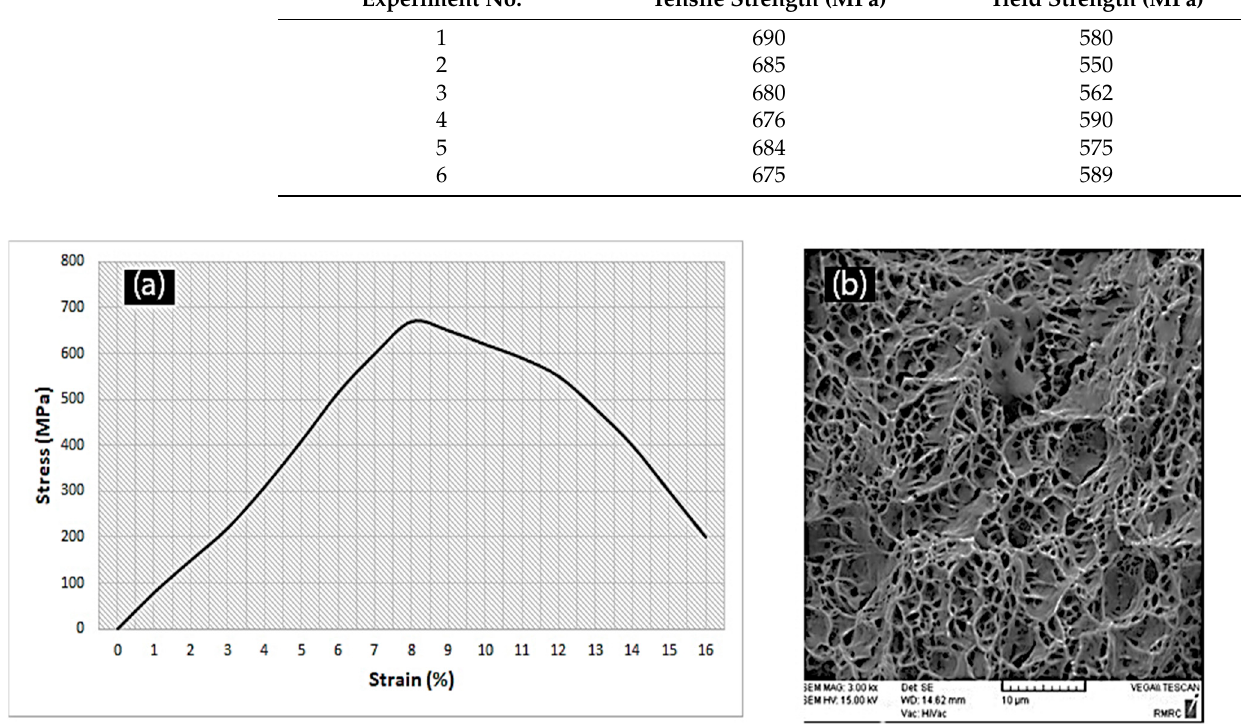
Table 4. Tensile properties of welded joints. Experiment No.